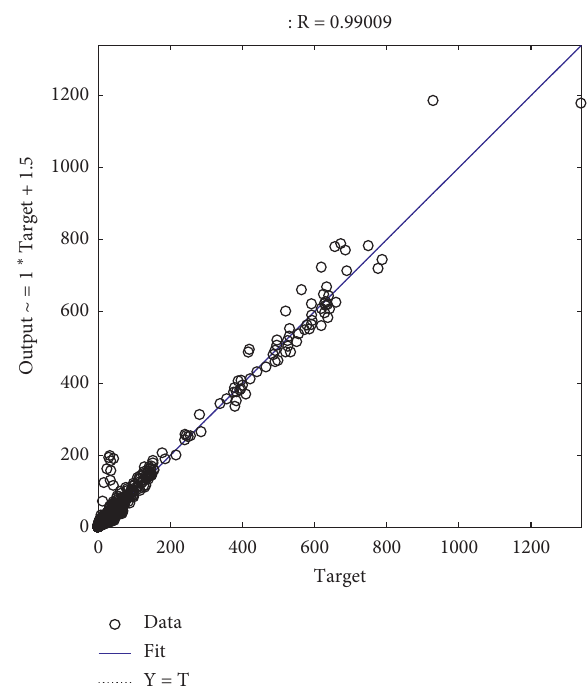
Figure 7: The prediction correlation relationship of BP neural network